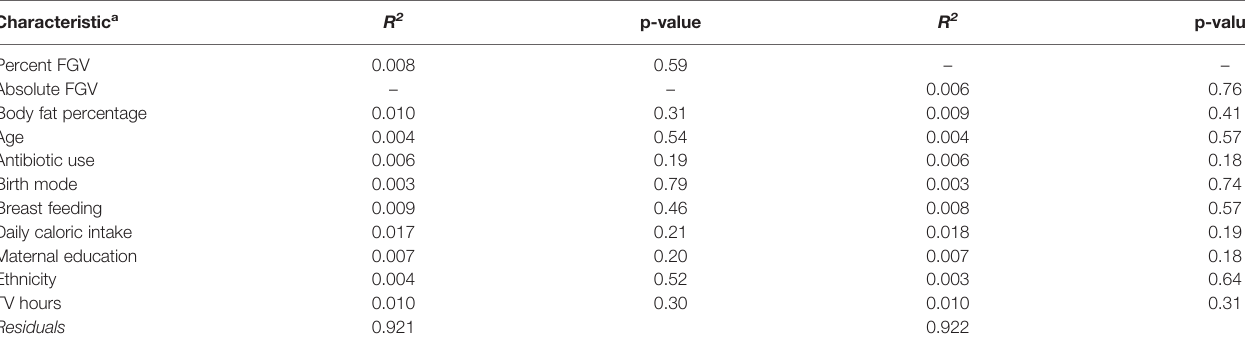
TABLE 3 | Multivariable PERMANOVA analyses to identify variation (R 2 ) in MetaCyc predicted pathway beta diversity (Bray-Curtis dissimilarity) explained by study characteristics. Characteristic a R 2 p-value R 2 p-value Percent FGV – Absolute